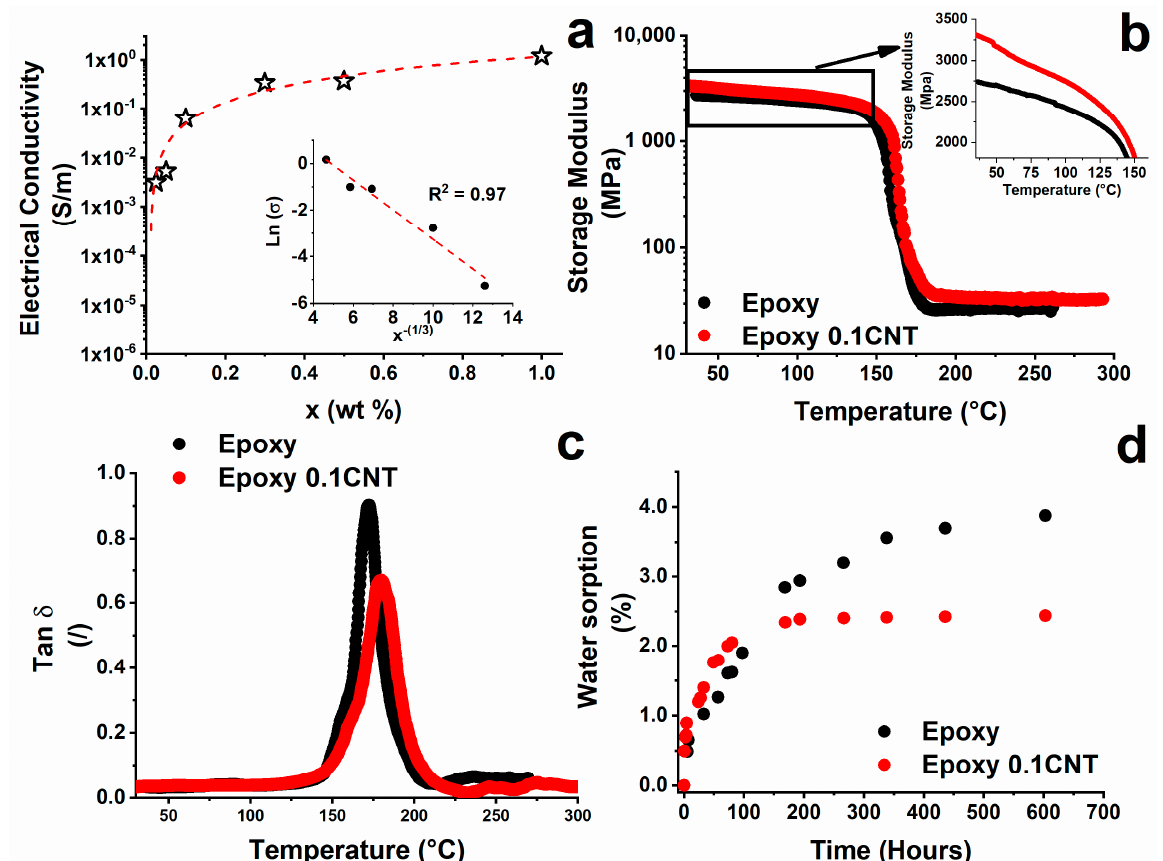
Figure 1. ( a ) Volume electrical conductivity vs. CNT weight percentage (inset: electrical conductivity versus x − 1/3 for CNT weight percentage (x) above the EPT); ( b ) storage modulus; ( c ) tan δ of the unfilled epoxy and filled epoxy with 0.1% by weight of multi-walled carbon nanotubes; ( d ) water uptake as a function of the immersion time for unfilled and filled epoxy resin.